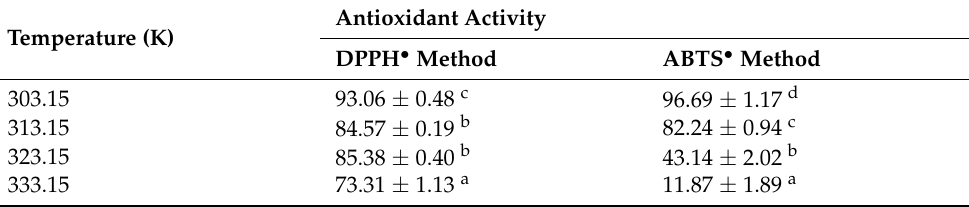
Table 7. Antioxidant activities of Kyoho skin extracts as affected by drying temperature 1 .